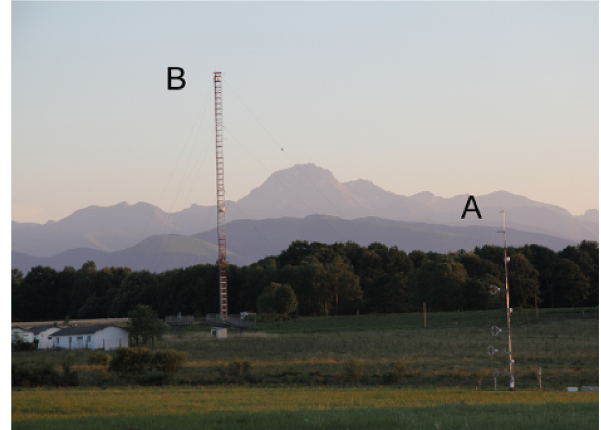
Figure 1. The figure is showing the two main measurement tow- ers and the Pyrenees mountain range in the background. The small divergence site tower is marked with A and taller 60m tower is marked with